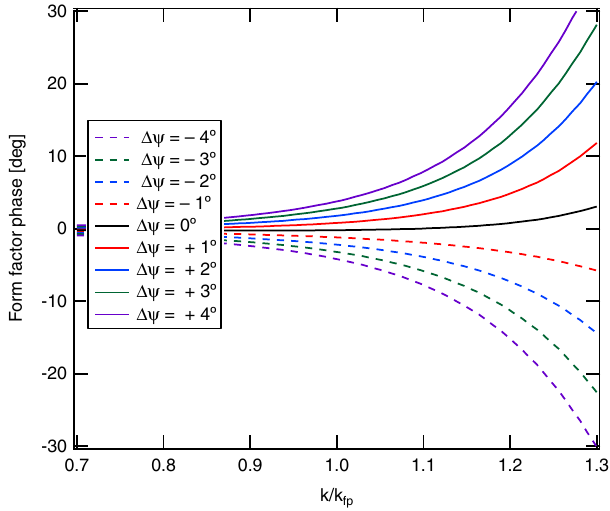
FIG. 18. Phase of the bunch form factor as determined by the implicit scalar approach, for the MAX III parameters, as a function of the harmonic cavity voltage ratio k normalized to the flat potential voltage ratio k . The curves are plotted for fp − ψ different values of Δ ψ ¼ ψ h h; fp